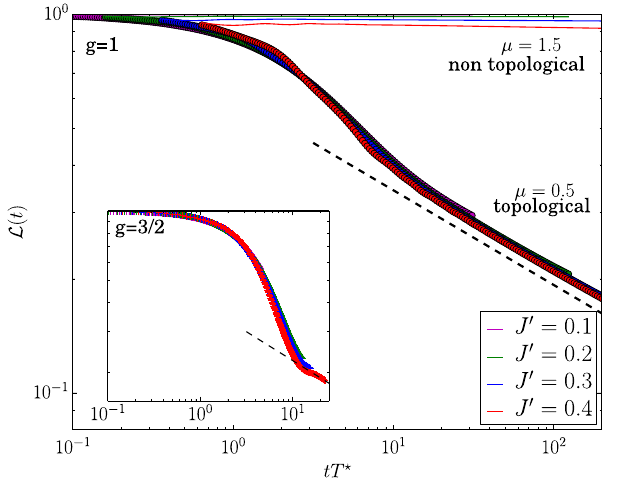
FIG. 3. Loschmidt echo after a quench of the tunneling between a (noninteracting) normal lead and a topologically trivial gapped phase with gap Δ . We choose L ¼ 4000 , J 0 ¼ 1 1 . 0 , and , Δ obtain a trivial band insulator with gap Δ ¼ μ − 1 . The Losch- 2 s ¼ midt echo exhibits a clear power-law behavior as a function of time, with a small exponent that scales as Δ − 2 (inset). Results for a nonzero superconducting gap Δ , μ ¼ 0 . 5 , 2